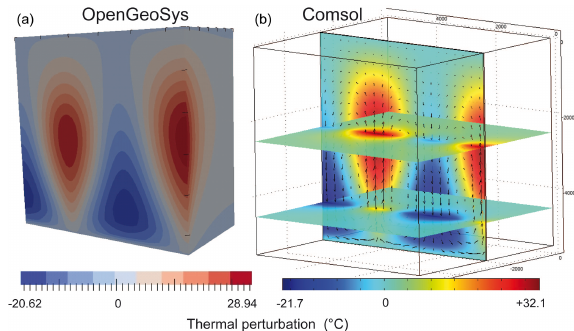
Figure B1. Benchmark experiment for a 40m wide fault zone em- bedded in impervious host rock (cube of 5.5km), as in the Magri et al. (2017) study (a) . Our result (b) indicates slight differences in temperature perturbation (see text), but the convective pattern is identical.